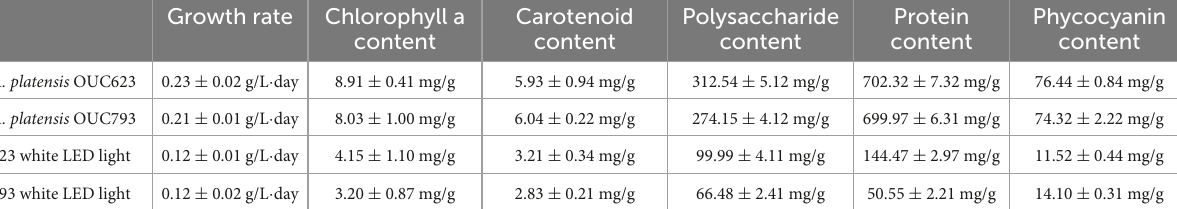
TABLE 9 Growth rate and organic matter content of A. platensis OUC623 and Arthrospira platensis OUC793 under optimized light